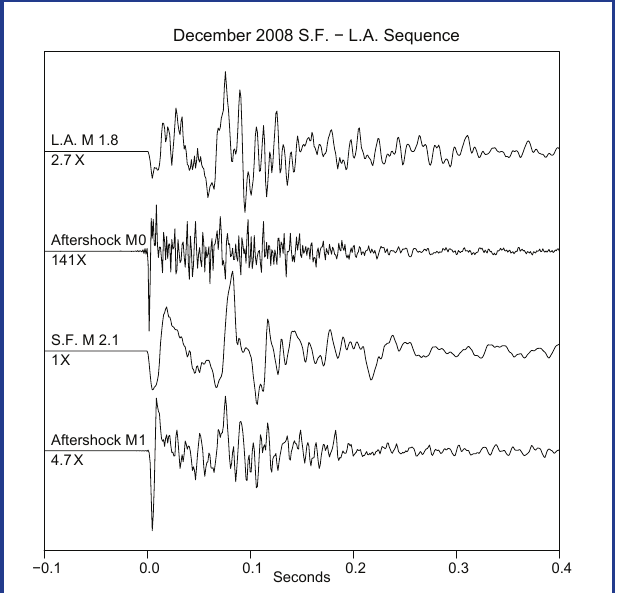
Figure 9. Seismograms from an SF and LA repeating earthquake sequence that occurred in December 2008. This earthquake was recorded on a 3-component seismometer deployed within the EUE tubing at a position just above the SAFOD observatory.